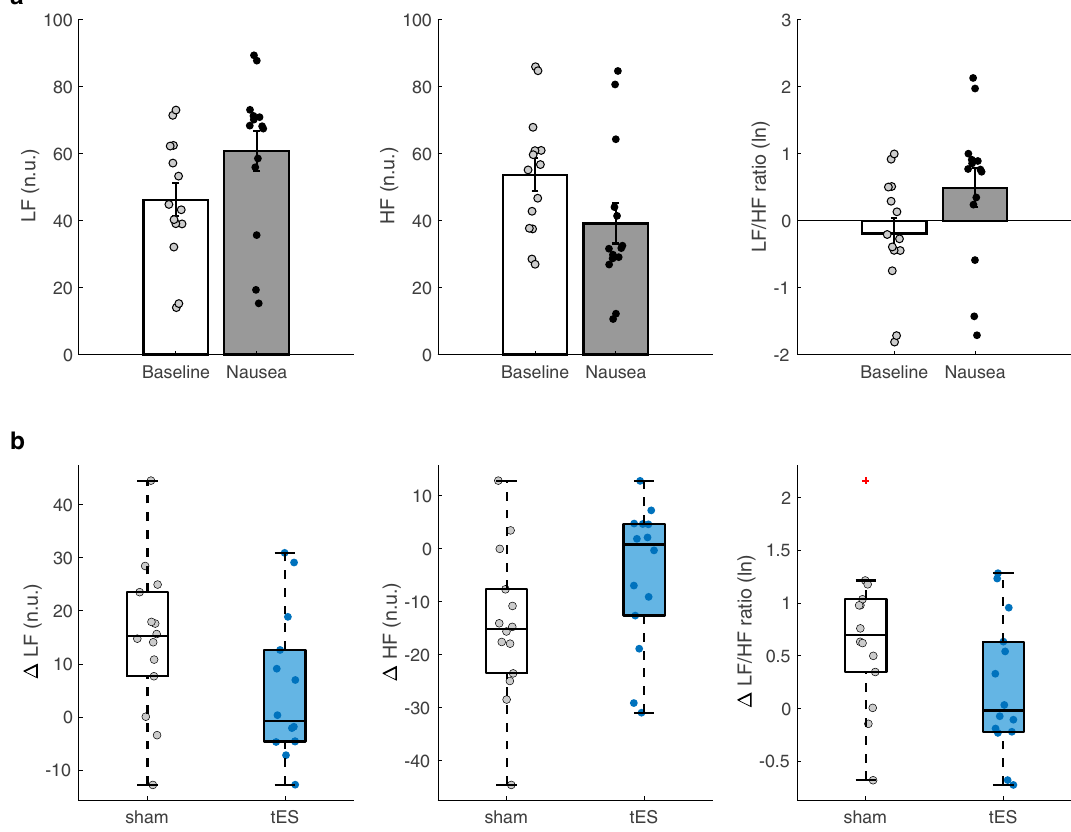
Figure 1. Spectral heart rate variability (HRV) measurements between participants at baseline and “Nausea” section, and between sham and transauricular electrical stimulation (tES) condition. (a) Average spectral power of low frequency (LF) and high frequency (HF), and LF/HF power ratio in response to nauseogenic stimuli. (b) Average change in LF, HF and LF/HF ratio in participants during sham and tES condition. Error bars represent standard error of the mean (SEM). The box plot central marks, box edges and whiskers represent medians, 25th to 75th percentiles and data range, respectively. The box plot also shows an outlier (red plus) in the sham condition for LF/HF